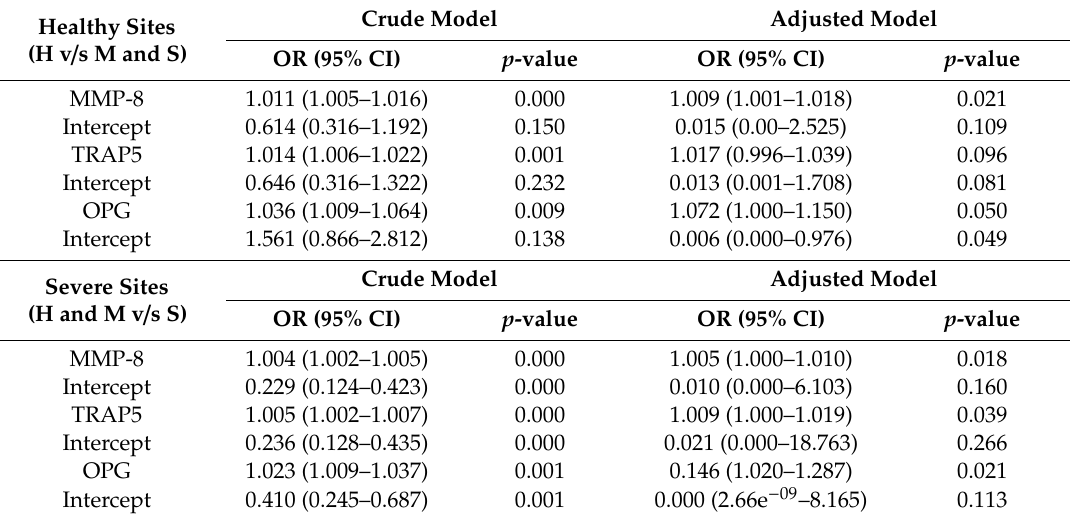
Table 3. Linear regression models to identify biomarkers’ potential to identify healthy sites (healthy versus mild and severe periodontitis sites) and severe periodontitis sites (healthy plus mild versus severe periodontitis